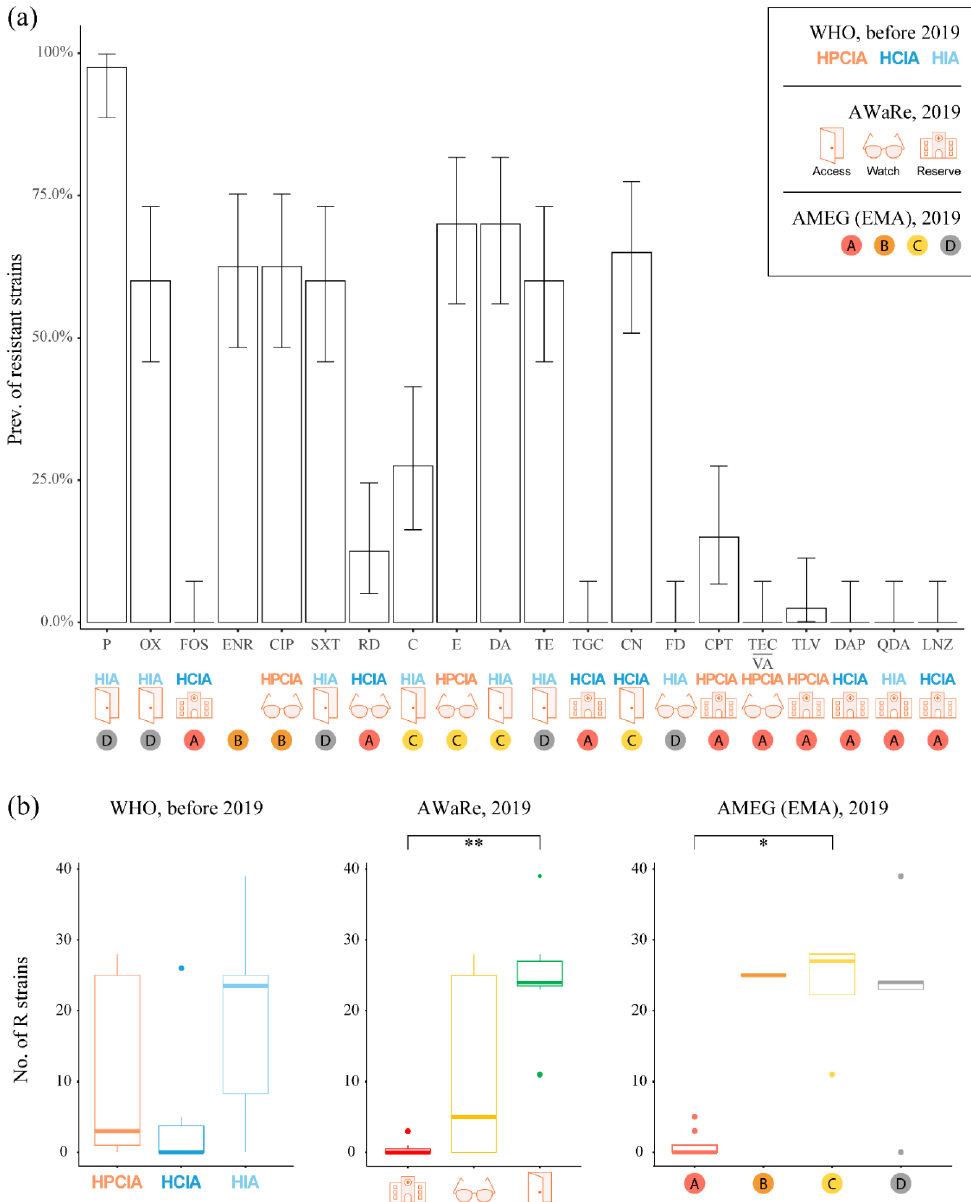
Figure 1. Bar plot of the prevalence of resistant strains ( a ). The height of the bars represents the point estimate prevalence of resistantstrains (R) to each antibacterial, with error bars indicating the 90% confidence intervals. Under the antibacterial name, World Health Organization (WHO and AWaRe) and European Medicines Agency (AMEG) classifications are reported. Box plots of the frequency of R strains ( b ). Data are aggregated by WHO, AWaRe and AMEG categories (*: p < 0.05; **: p < 0.01). Category abbreviations: HPCIA: Highest Priority, Critically Important Antimicrobials; HCIA: High priority, Critically Important Antimicrobials; HIA: Highly Important Antimicrobials. Antibacterial abbreviations: P: penicillin G; OX: oxacillin; FOS: fosfomycin; ENR: enrofloxacin; CIP: ciprofloxacin; SXT: trimethoprim ‐ sulfamethoxazole; RD: rifampicin; C: chloramphenicol; E: erythromycin; DA: clindamycin; TE: tetracycline; TGC: tigecycline; CN: gentamycin; FD: fusidic acid; CPT: ceftaroline; TEC/VA: teicoplanin/vancomycin; TLV: telavancin; DAP: daptomycin; QDA: quinupristin ‐ dalfopristin; LNZ: linezolid. Note: the colours are those used by WHO and EMA to identify the categories of antibacterials.